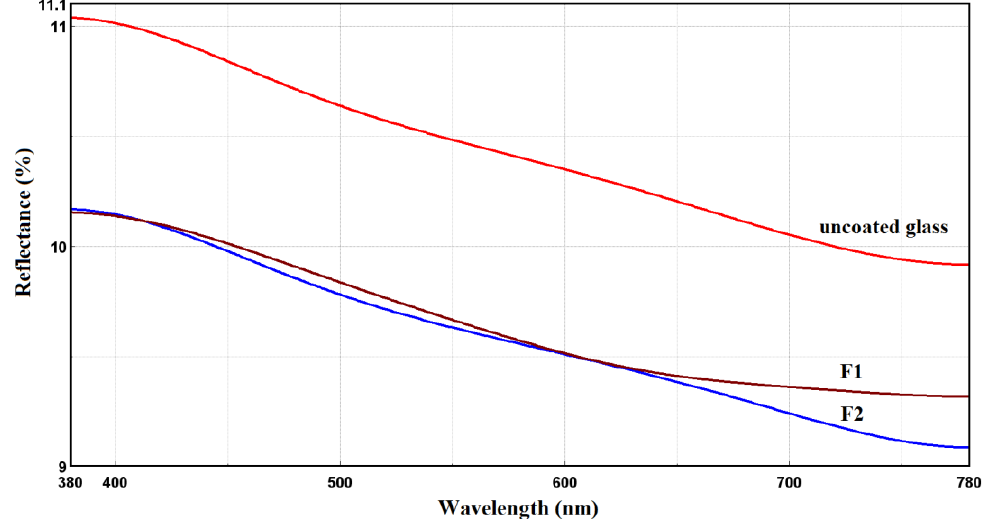
Figure 9. Diffuse reflectance spectra of the uncoated glass and the fluorinated hybrid coatings (TEOS/MTES/FS (F1) and TEOS/MTES/HDTMES/FS (F2)).